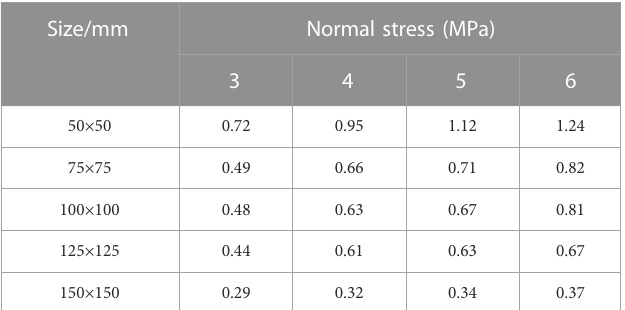
TABLE 11 SSSP (Chen et al.,